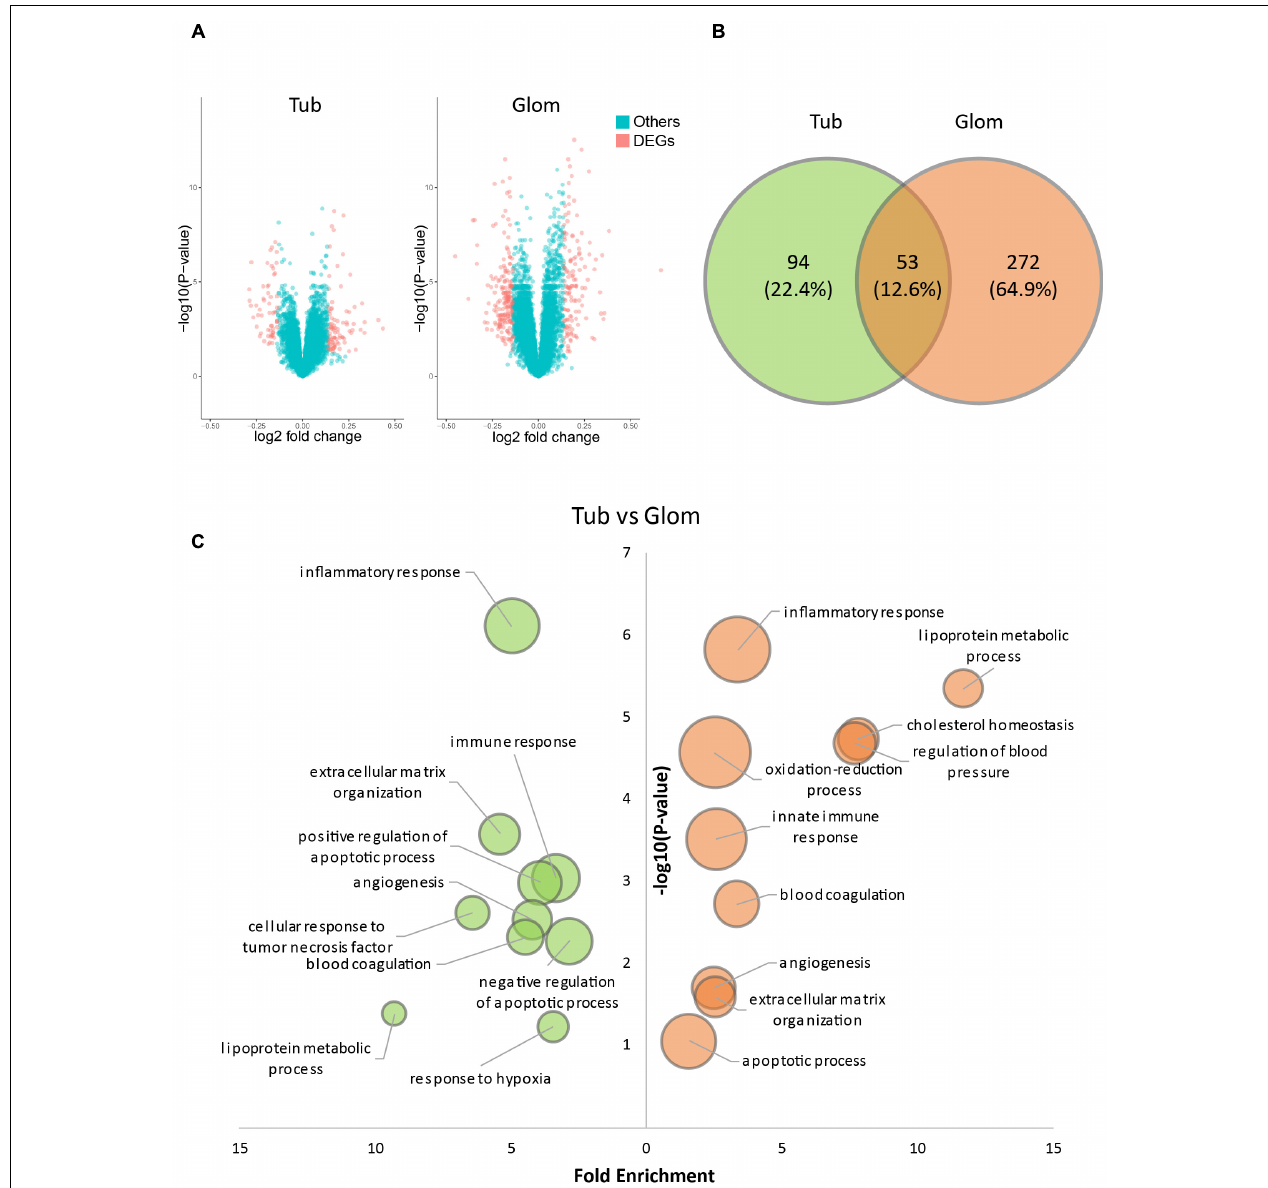
FIGURE 2 | Differentially expressed genes (DEGs) in tubules and glomeruli of HN patients. (A) Volcano plot of differentially expressed genes in tubules and glomeruli. (B) Venn diagram of DEGs in tubules (green) and glomeruli (orange). (C) Bubble plot of enriched GO terms of DEGs of tubules (green) and glomeruli (orange). X -axis is fold enrichment, Y -axis is related with p -value of enrichment analysis. Bubble size changes with the count of targets in this term.